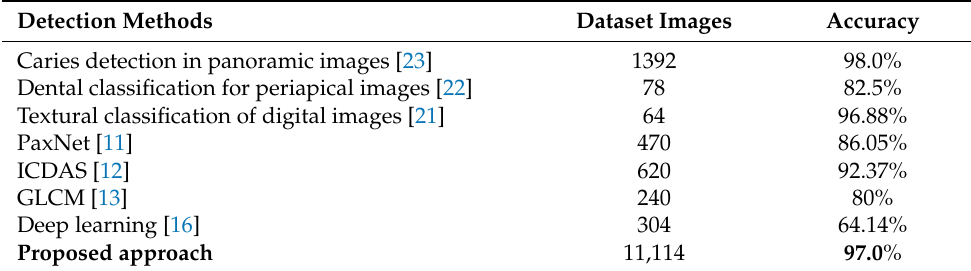
Table 1. Comparison of various caries detection